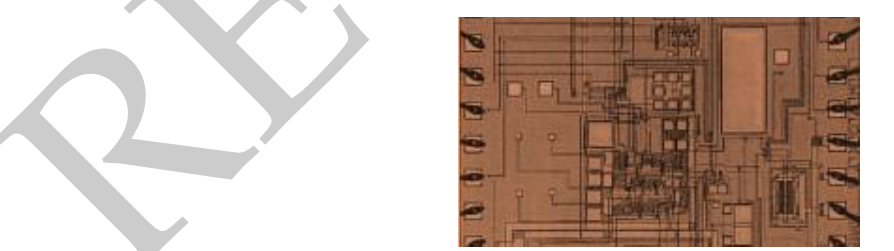
Figure 6. Chip microphotograph of the CTA circuit in CMOS FD-SOI 28-nm technology and 0.266-mm 2 area.